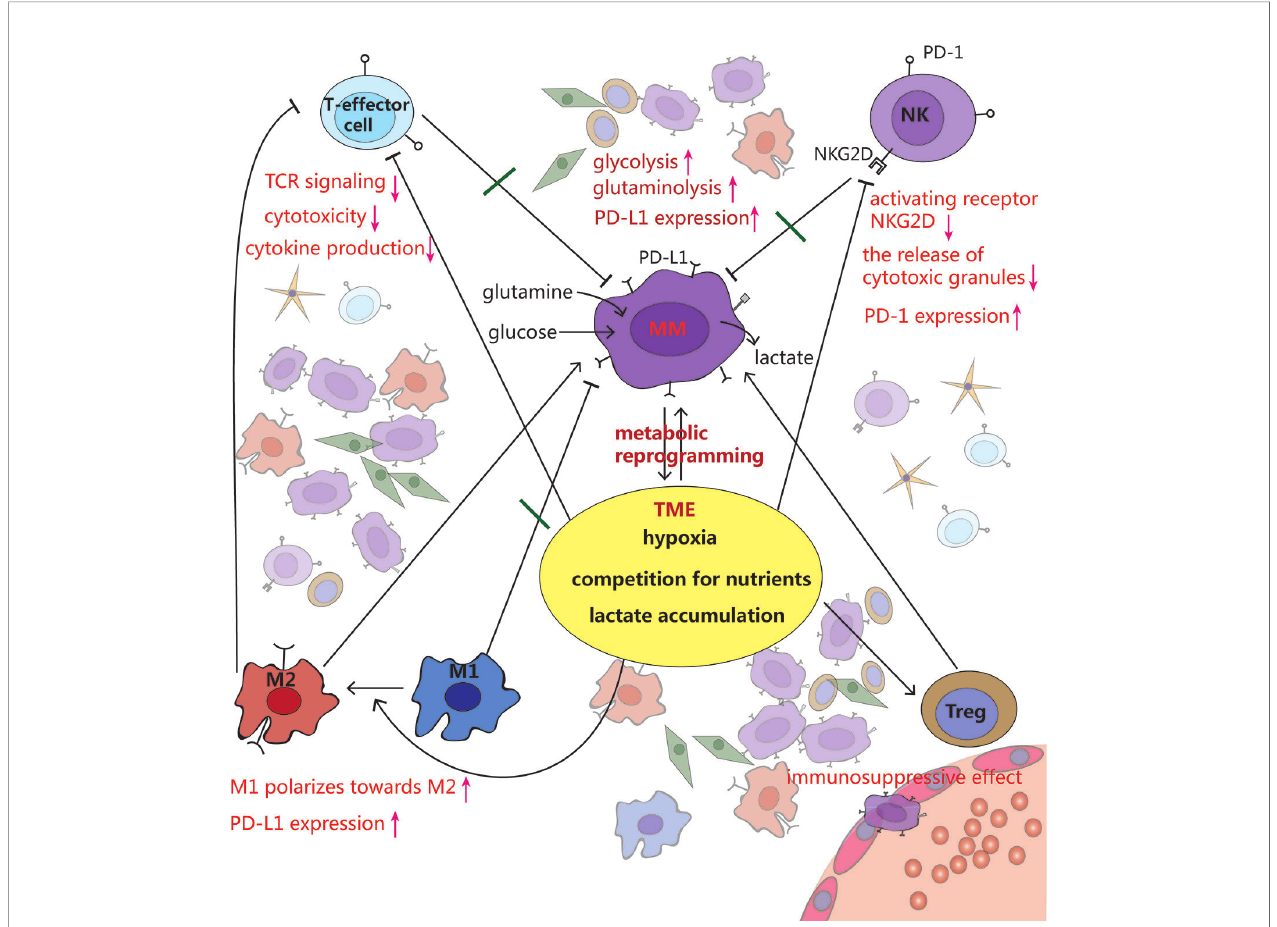
FIGURE 3 | Crosstalk among MM cells, immune cells and tumor microenvironment (TME). MM cells rewire metabolism, such as increased glycolysis and glutaminolysis, to adapt to the hypoxic TME. Meanwhile, this makes the TME more anoxic, acidic and less nutritious, which inhibits T effector cells and NK cells, stimulates polarization from pro-in fl ammatory M1 macrophages toward a cancer-promoting M2 phenotype, as well as promotes Tregs development, leading to immune